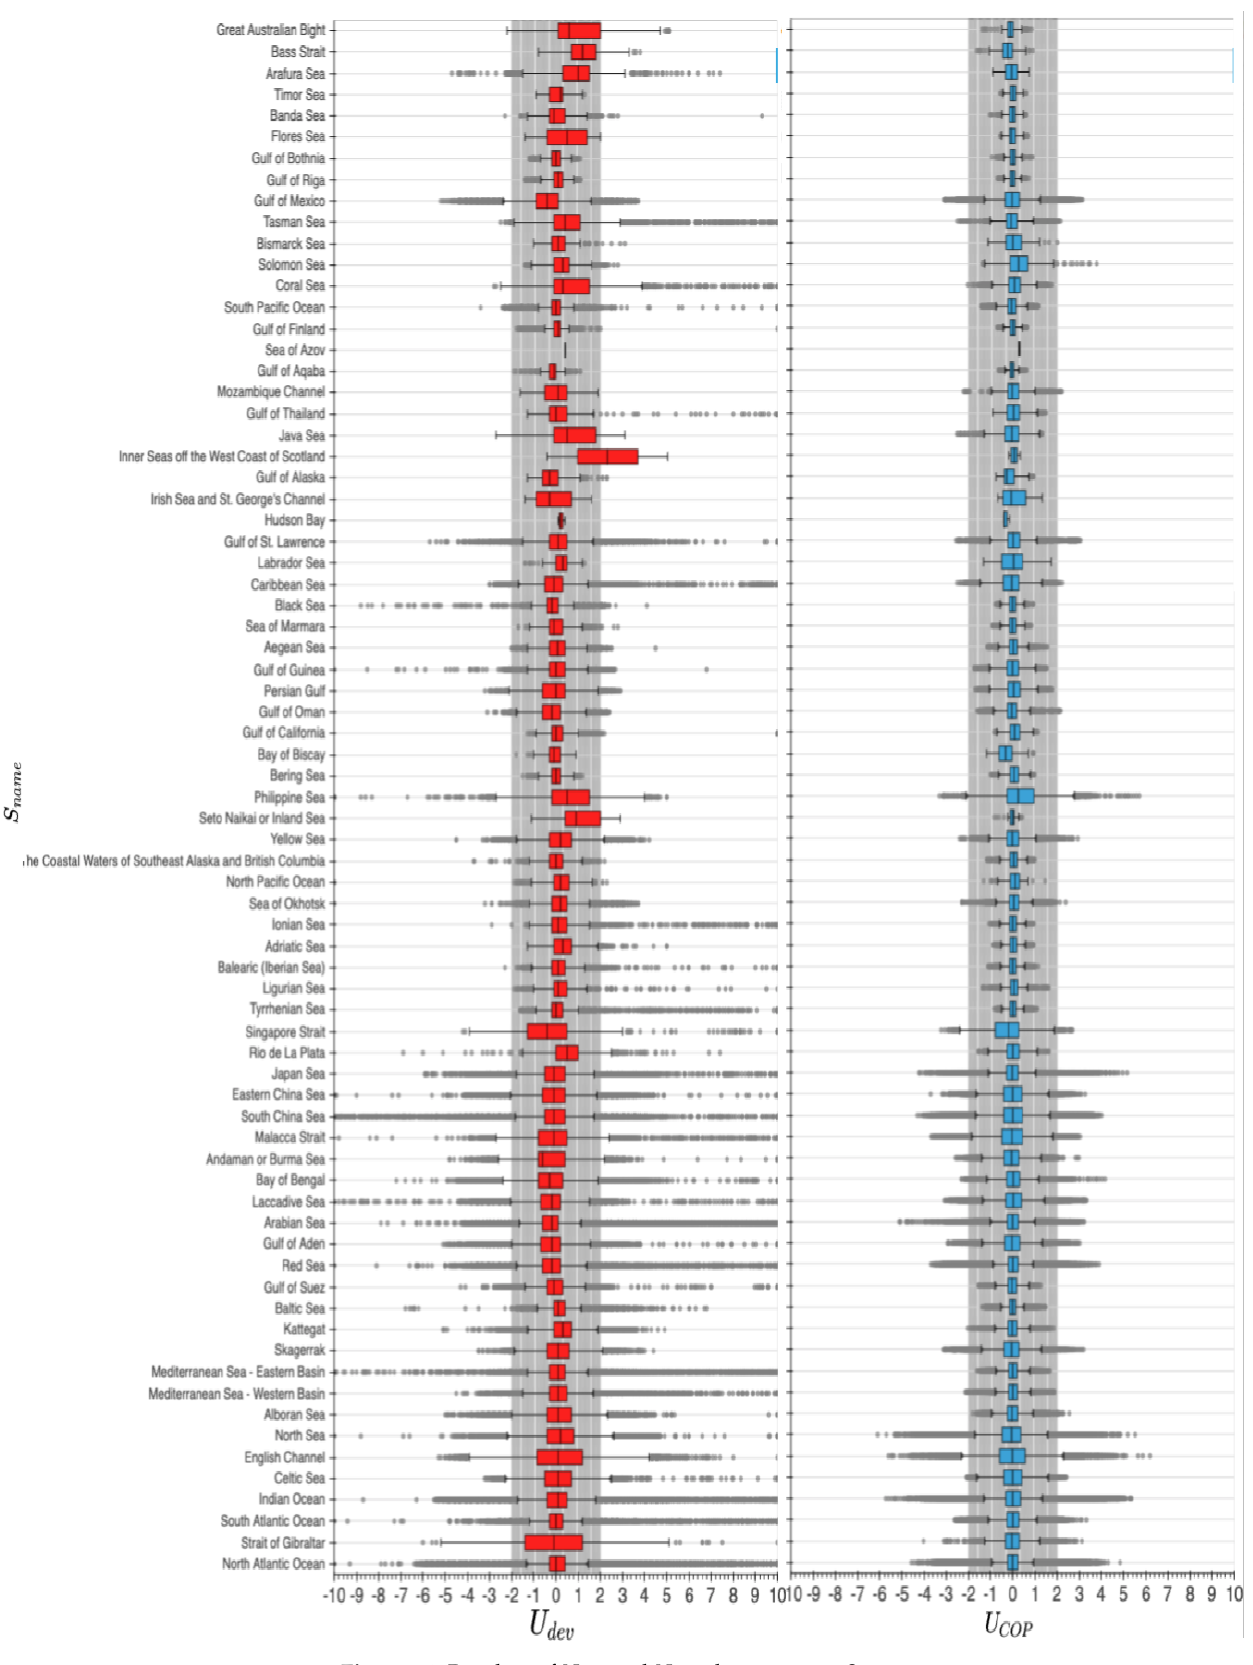
Figure 14. Barplots of U dev and U COP by sea name S name